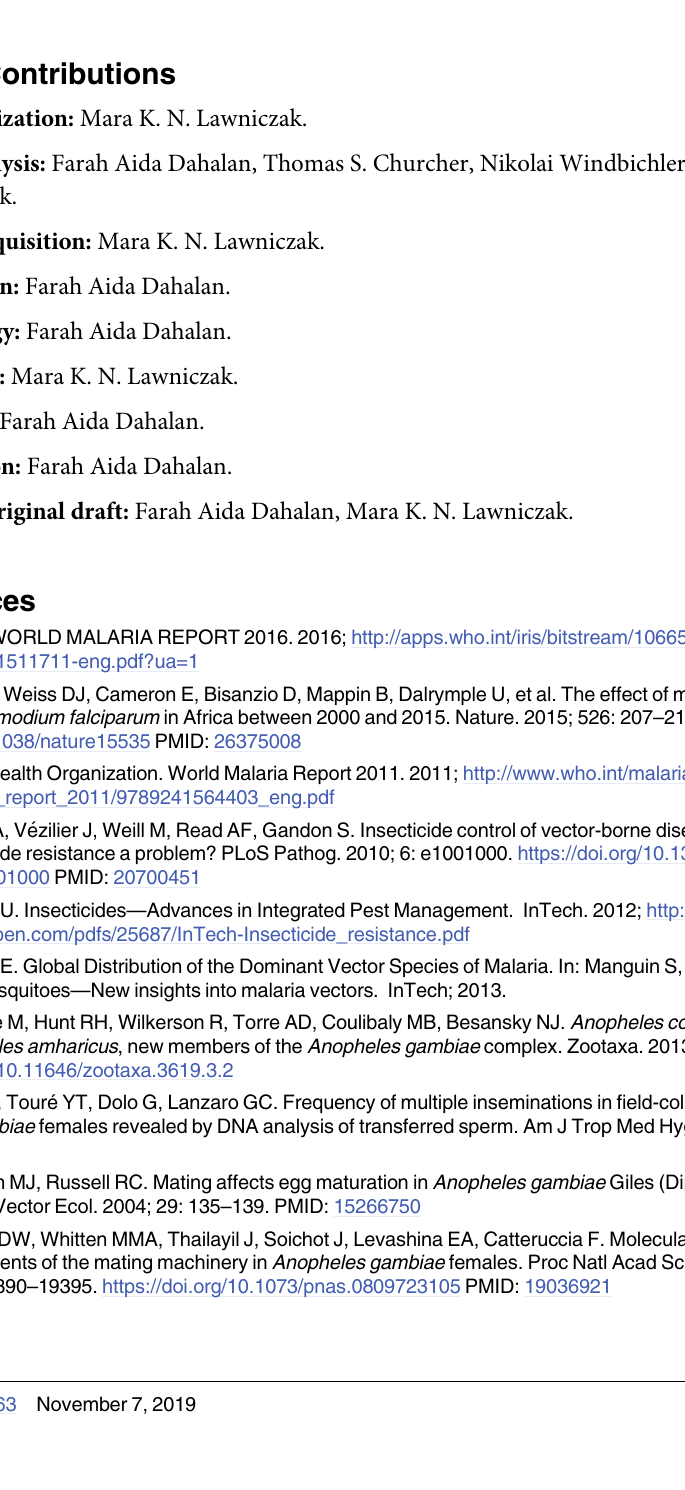
S1 Table. List of all annotated genes in Anopheles gambiae and how they are affected by mating in both sugarfed and bloodfed midguts as well as by 20E